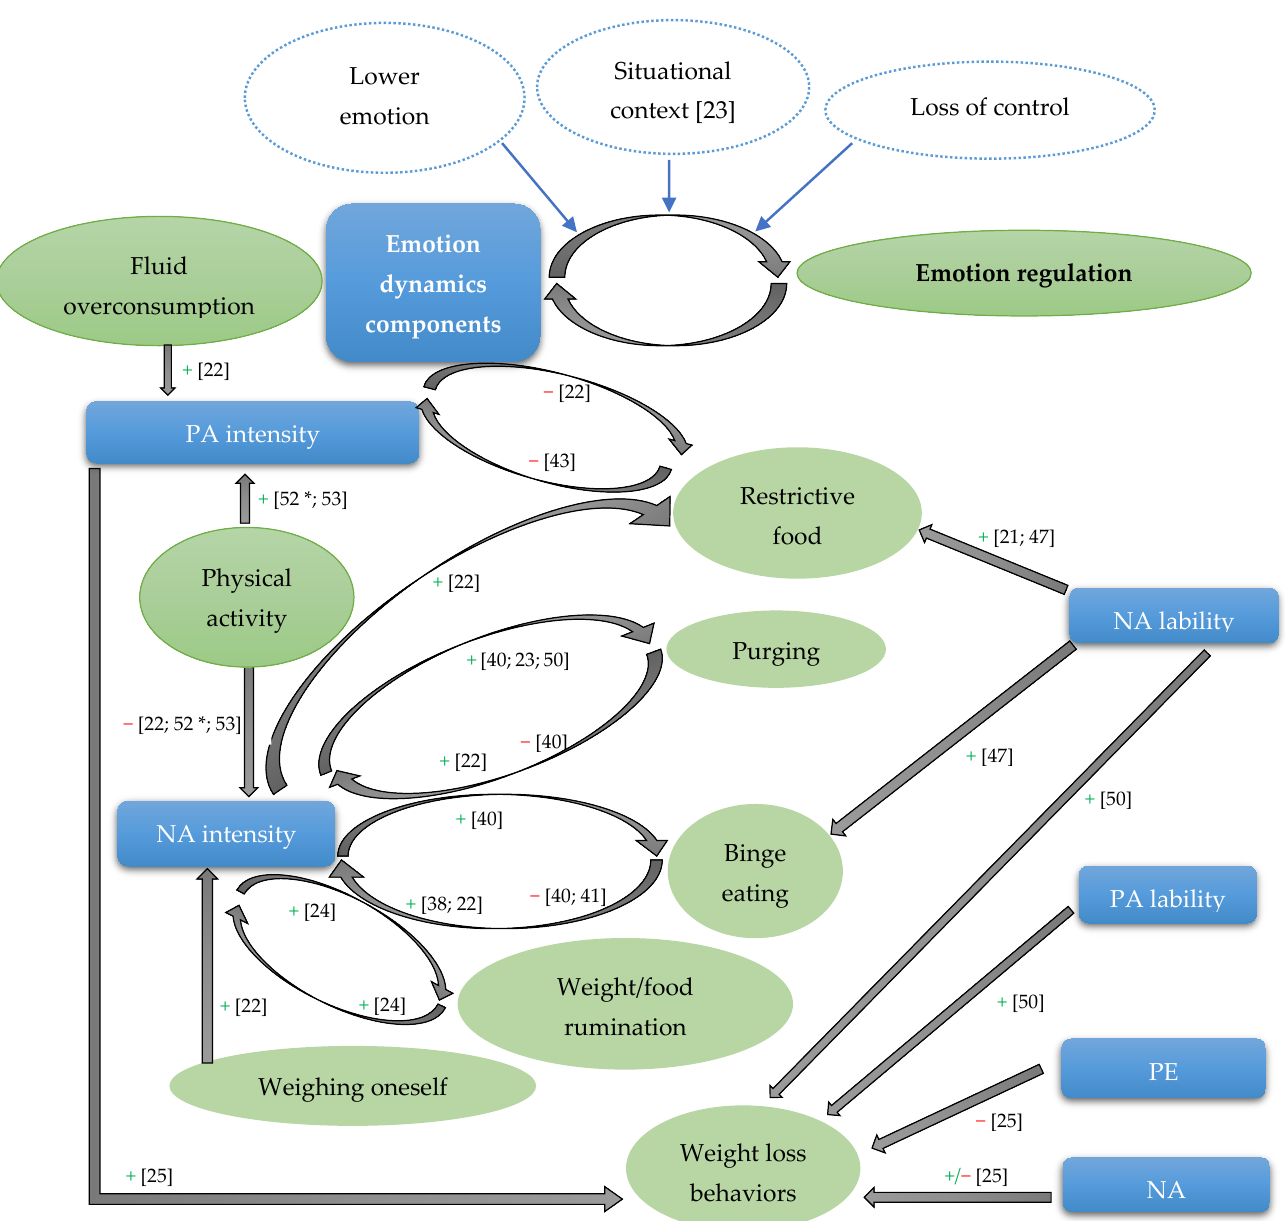
Figure 2. Schematic representation of the relationships of emotion dynamics components and disordered emotion regulation strategies in AN based on empirical data on the significant associations between these constructs. Note. AN—anorexia nervosa; NA—negative affect; PA—positive affect; PE—positive emotion; +—positive association; − —negative association. Weight loss behaviors comprise vomiting, laxative - use, exercising, weighing, checking for fat, and restricting. * The effect did not hold statistical significance when correcting for multiple testing.